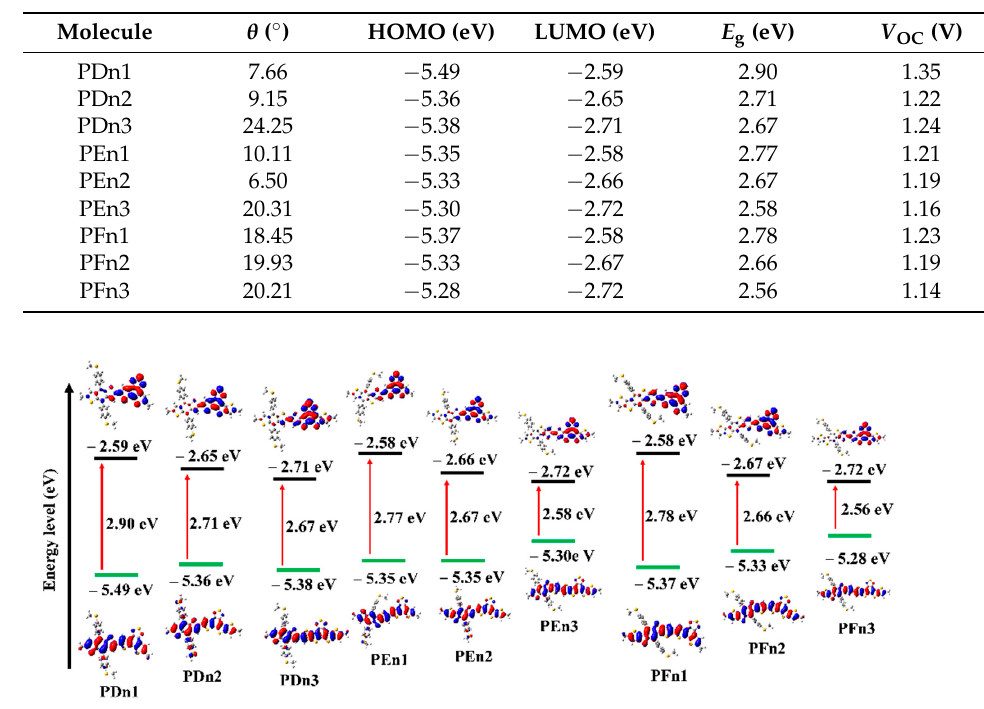
Table 1. The optimized geometry of oligomers: dihedral angles ( θ ) of the D-A block, energies of HOMO, LUMO, E g values, and V OC .